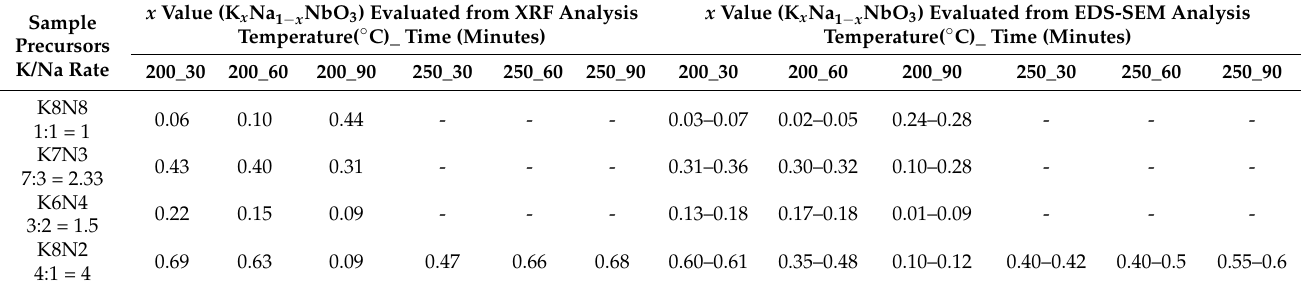
Table 1. Molar fraction x variation with temperature, HTMW dwelling time and concentration of the precursor alkaline